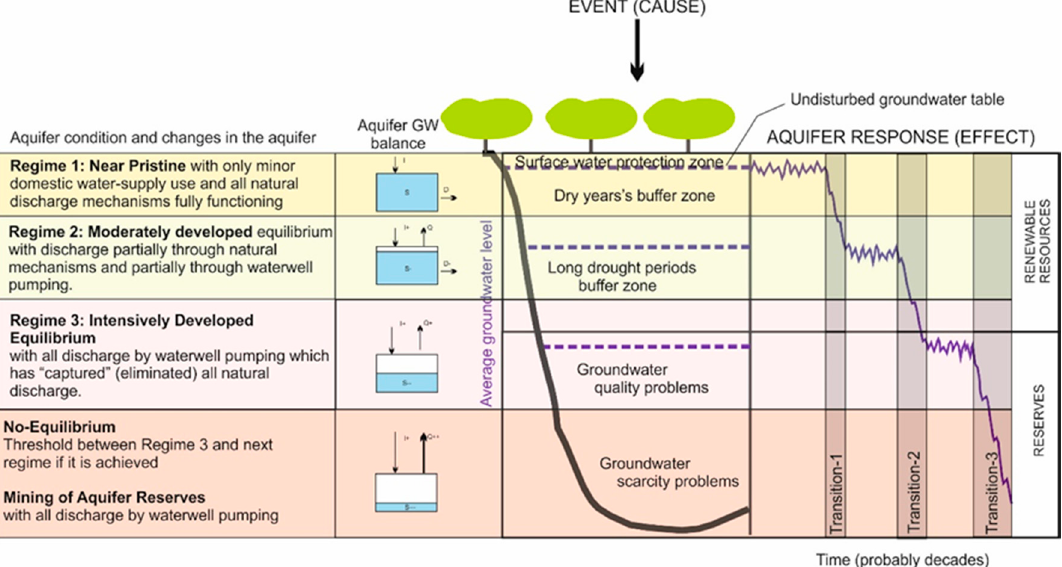
Figure 2. Stages of groundwater resource development and the implications of storage depletion (adapted from [29]). We assume the piezometric level as descriptive variable. The piezometric level indicates time series of the groundwater system state. The grey area represents the state shift made evident by the changes manifested the system. Transition-1 shows a decrease of the capillary finger with the corresponding affection to terrestrial groundwater dependent ecosystems, as well as changes in surface water and groundwater interactions (discharges to rivers and wetlands reduced). Transition-2 shows changes in groundwater heads (decreasing) with implications on groundwater availability. Transition-3 implies changes in groundwater quality (possibly in groundwater hydrochemical facies) and associated problems of water scarcity. These three transitions also imply changes in hydraulic parameters (Transmissivity and Storability).